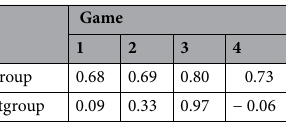
Table 1. Correlation between Y ij and Y ji for the ingroup and the